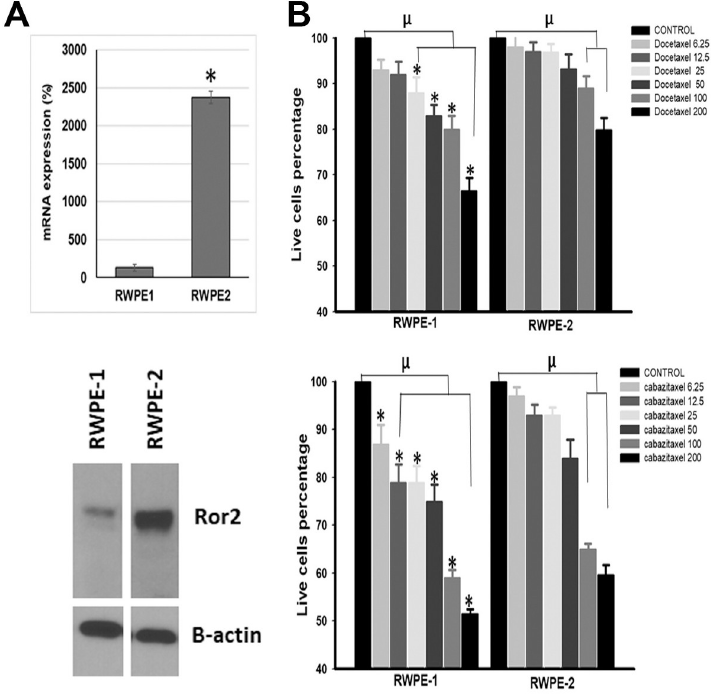
Fig 8. Effect of Ror2 expression levels on taxanes sensitivity in RWPE-1 and RWPE-2 prostatic epithelial cell lines. (A) mRNA (Top) and protein (Bottom) expression level for Ror2 in RPWE-1 and RWPE-2 cells quantified respectively by qRT-PCR and normalized to S15 mRNA (Top) and by western blotting using beta-actin as loading control (Bottom). (B) Growth curves of RWPE-1 and RWPE-2 cells in the presence of increasing concentrations of Doc and Cab. For the quantification data, the cells were fixed in 2% glutaraldehyde and stained with crystal violet then the optical density at 590 nm was measured using the Quad4 monochromators plate reader (TECAN Tecan Infinite M1000 Pro multi detection). Kruskal Wallis ANOVA followed by Dunn’s test was used to determine the significance of each dose compared to their respective control. Man-Whitney was used to compare Doc and Cab doses between RWPE-1 and RWPE-2. The symbol “ μ ” indicated that there is a significant difference between the dose in comparison to their respective control (p < 0.001) and, the symbol ‘ � ’ indicated that there is a significant difference between RWPE- 1 and RWPE-2 doses (p < 0.05). The graphs represent the mean ± SEM of three different